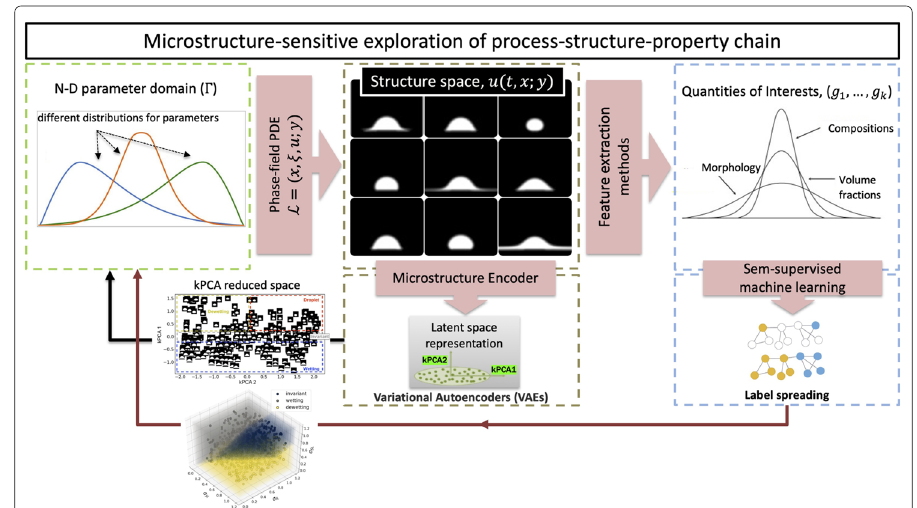
Fig. 1 Schematic representation of machine learning-assisted high-throughput phase-field modeling for exploration of process-structure-property chain in materials